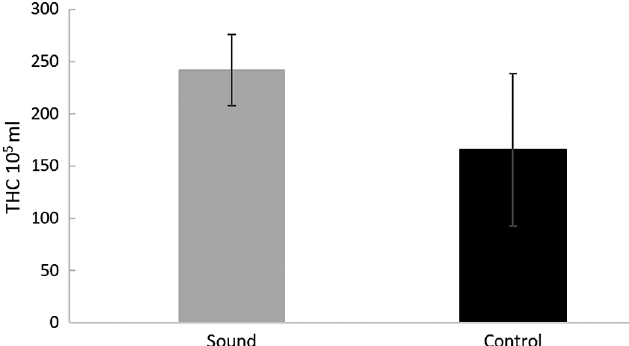
Fig. 4. Whiteleg shrimp total haemocyte count (THC- absolute) (individual animal means, n = 9 for both) in sound and control treatments at experimental completion after 8 wk. Error bars = 1 SD